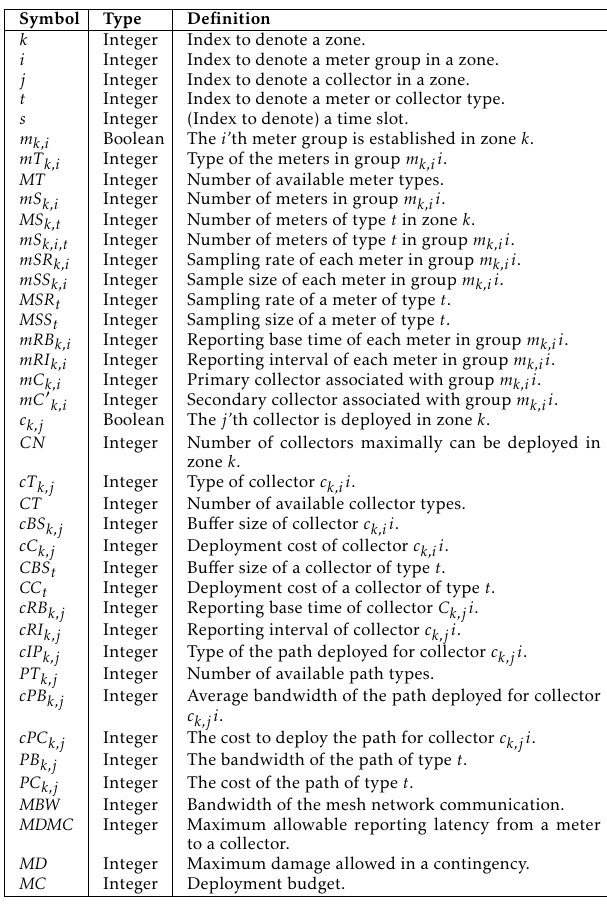
Figure 2. The architecture of the AMI resiliency configurations synthesis framework architecture. Table 1. Important Modeling